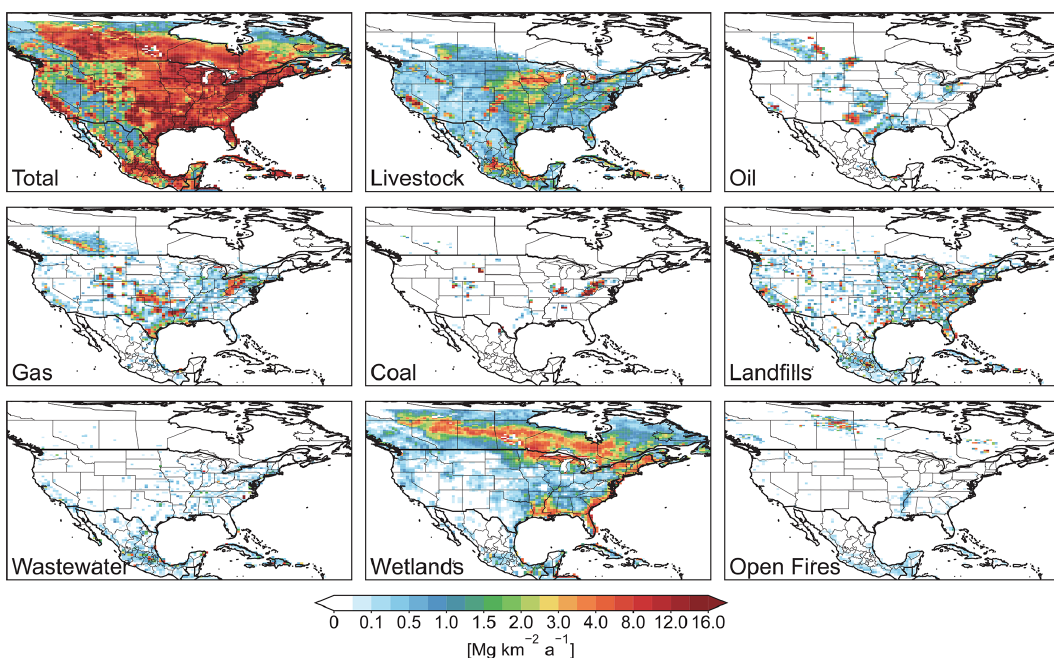
Figure 2. Prior estimates of methane emissions from individual sectors. Anthropogenic emissions are from spatially explicit versions of the EPA, ECCC, and INECC official national inventories. Wetland emissions are from the mean of the high-performance subset of the WetCHARTs inventory